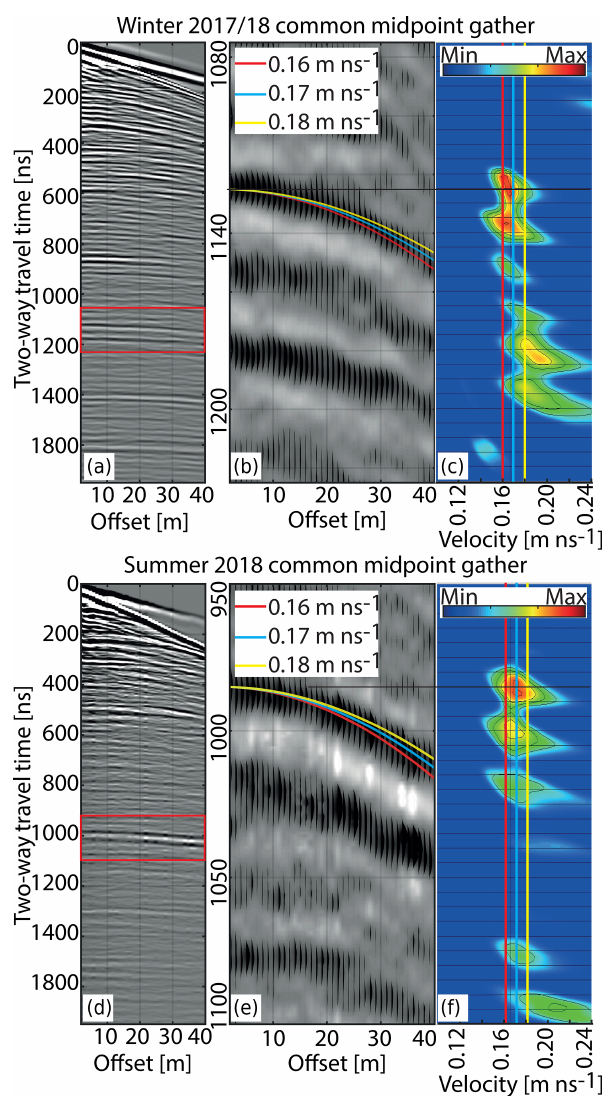
Figure 4. Common midpoint gather and velocity determination. Winter (April 2018): (a) the raw CMP gather; (b) zoom of the raw gather over the englacial reflection with second-order normal move- out (NMO) curves using 0.16, 0.17, and 0.18mns − 1 . (c) Semblance display using second-order NMO for the zoom section from (b)